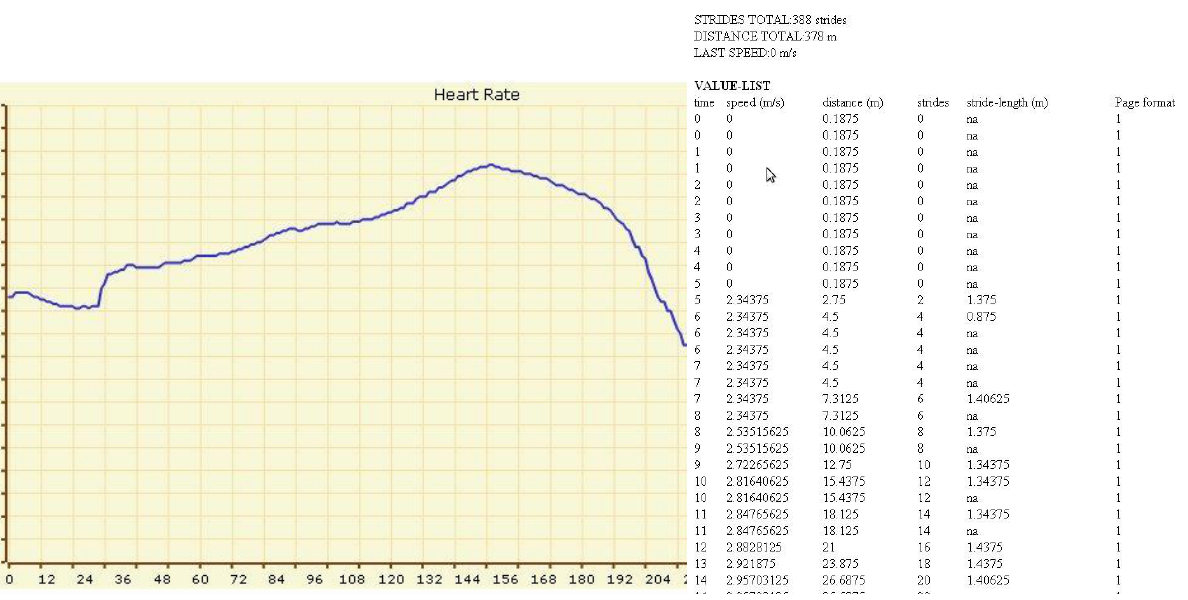
Figure 10 . Charts and tables to present training